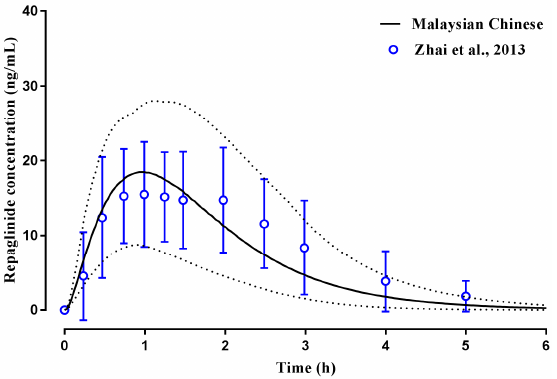
Figure 6. Simulated plasma concentration–time profile of repaglinide in healthy Malaysian Chinese adults. A 2 mg oral dose of repaglinide was administered once daily to adult healthy Chinese volunteers ( n = 22) using the Malaysian Chinese population group. Solid lines represent mean predictions with dotted lines representing the 5th and 95th percentile ranges. Open circles represent data for the observed study [44].